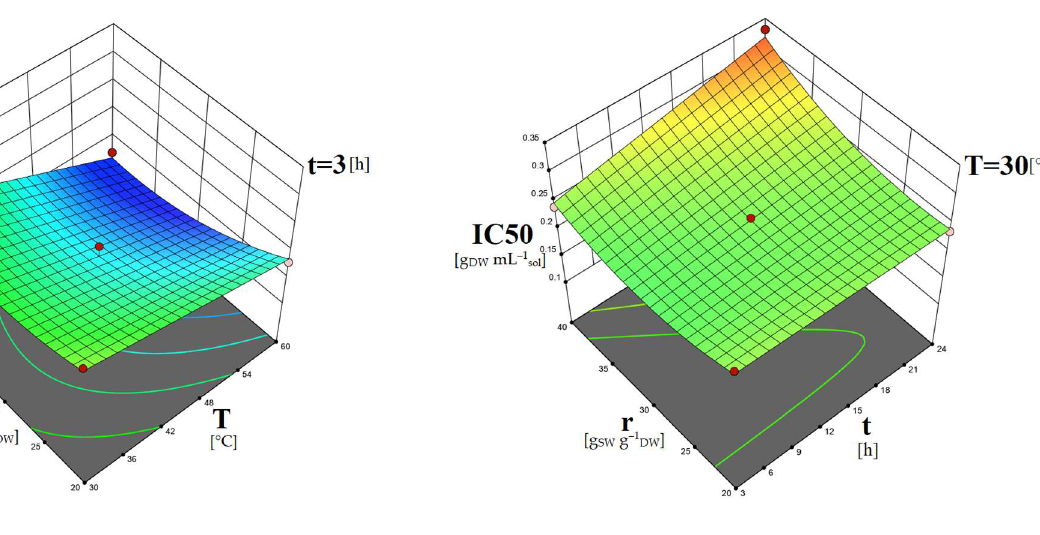
Figure 2. Three-dimensional surface plots showing the combined effects of temperature and sol- vent–biomass ratio ( a – c ) on TPC [mg GAE g –1DW ] of the C. vulgaris extracts obtained using DES1/w solvent.